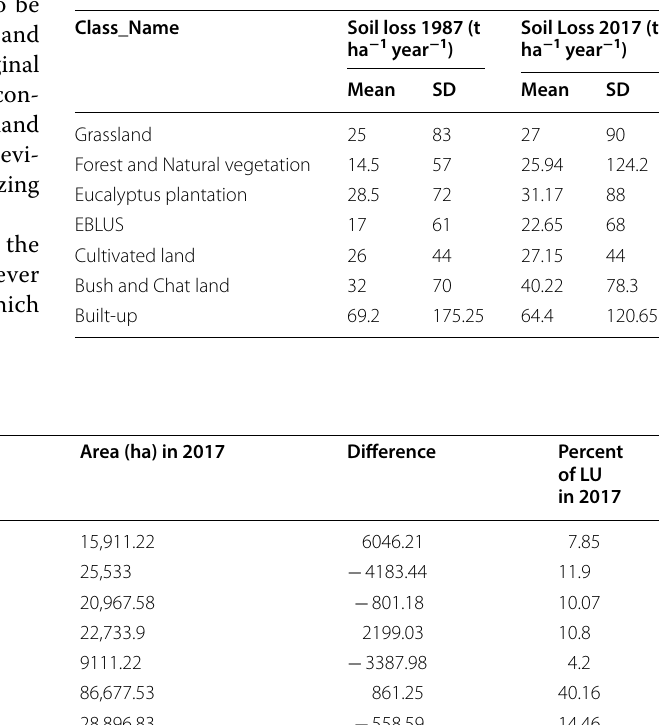
Table 7 The soil loss change in land covers (1987 to